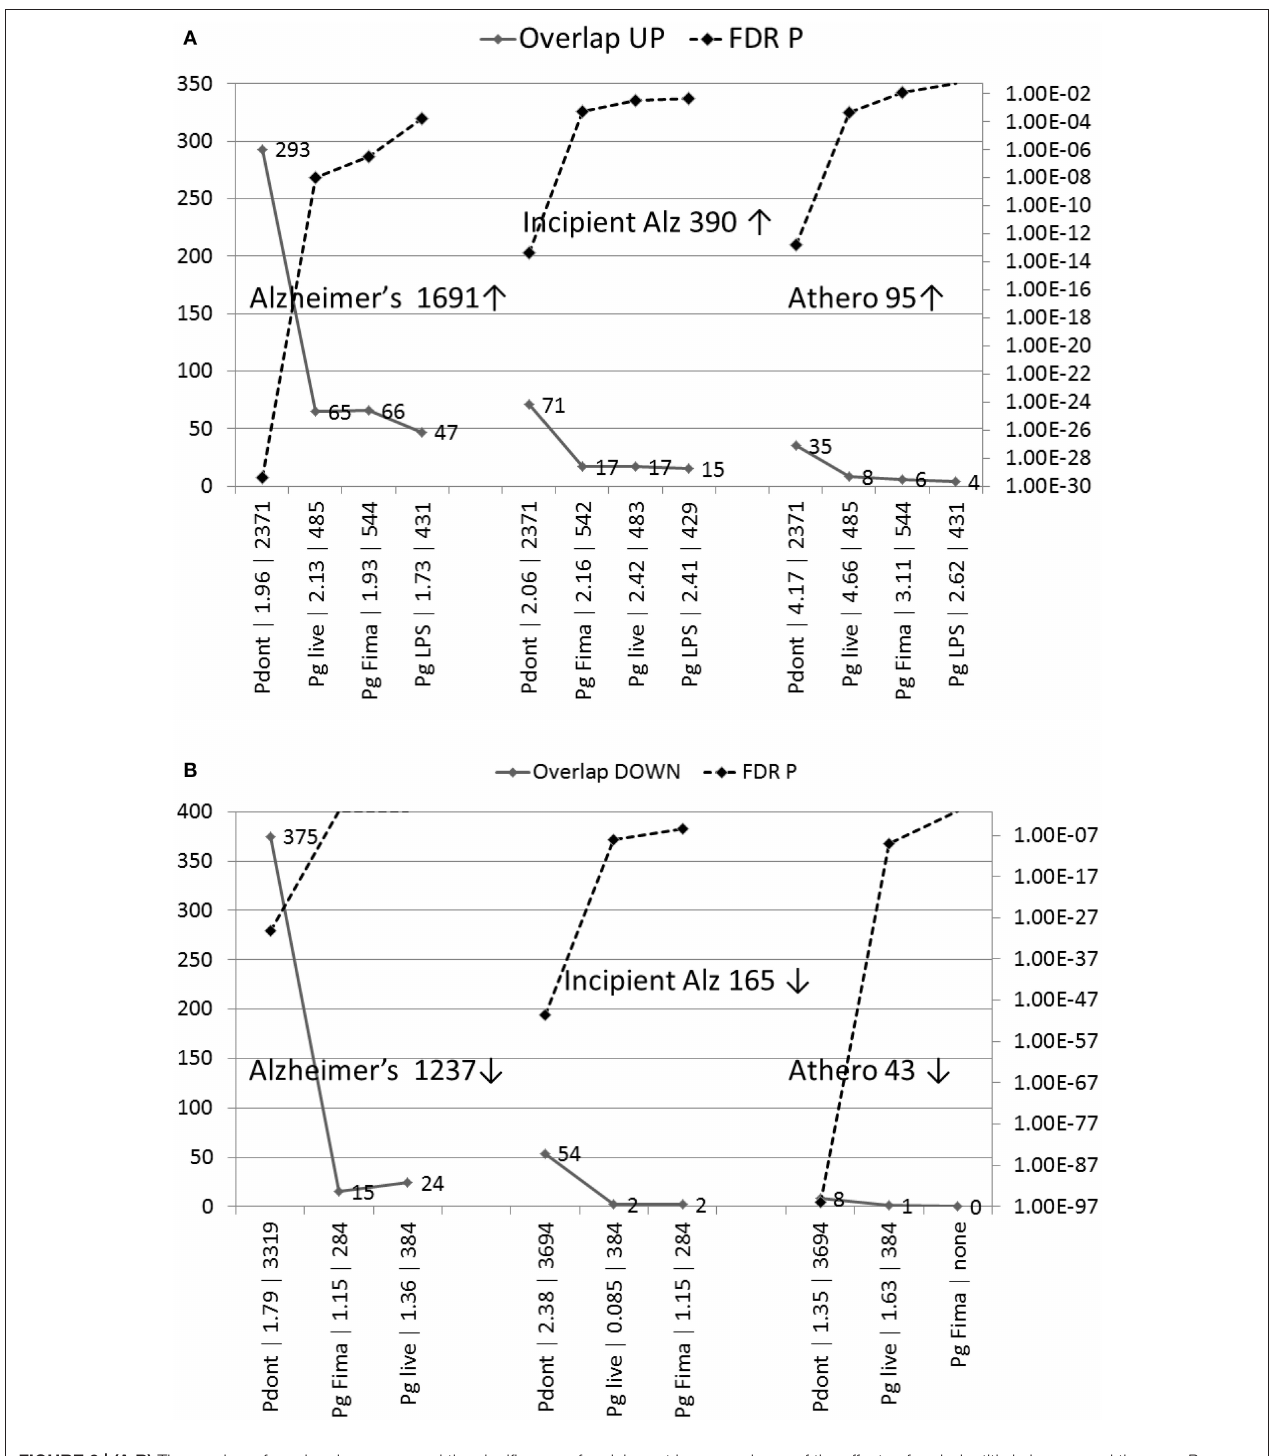
FIGURE 2 | (A,B) The number of overlapping genes and the significance of enrichment in comparisons of the effects of periodontitis in human oral tissue or P. gingivalis in human macrophages with microarrays from the AD hippocampus or from unstable atherosclerotic plaques (Athero). (A) Upregulated genes; (B) Down-regulated genes. Pdont, periodontitis; Pg live, live P. gingivalis ; Pg LPS, P. gingivalis -lipopolysaccharide; Pg Fima, P. gingivalis fimbrial component. The labels on the X-axis (e.g., Pdont | 1.96 | 2371) correspond to these conditions, followed by observed/expected values, and the number of misregulated genes in the periodontitis or P. gingivalis microarrays. The maximum of the Y-axis (FDR q -value) is set at p = 0.05 and invisible points above this line are non-significant. No down-regulated data were available for down-regulated genes in the case of P. gingivalis LPS. The number of up or down-regulated genes in the Alzheimer’s (Alz) or atherosclerosis datasets are also